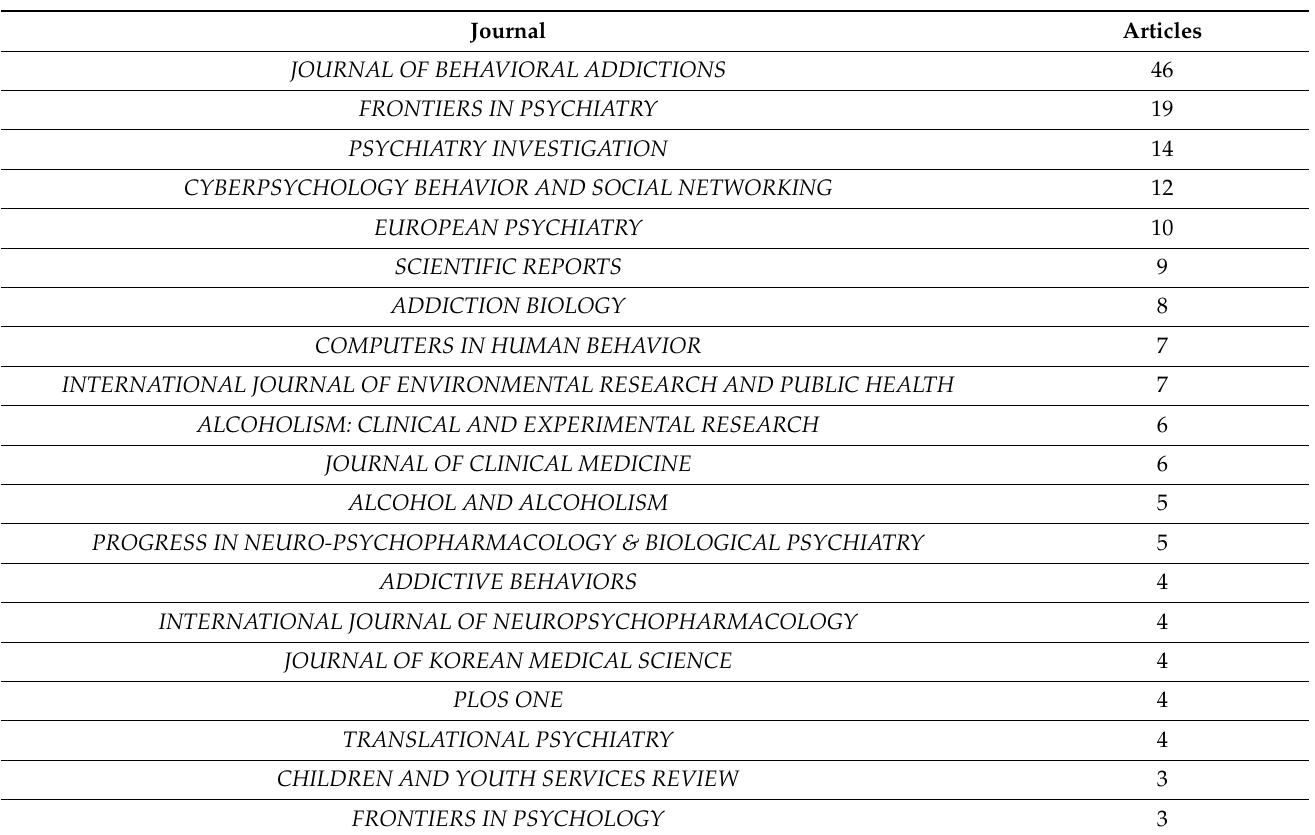
Table 1. The top 20 most productive journals.